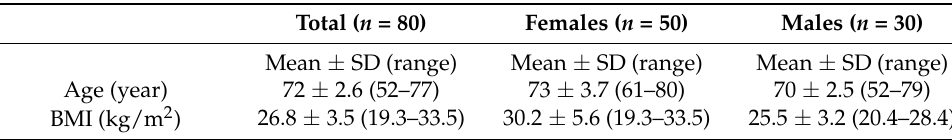
Table 1. Patient demographic and BMI